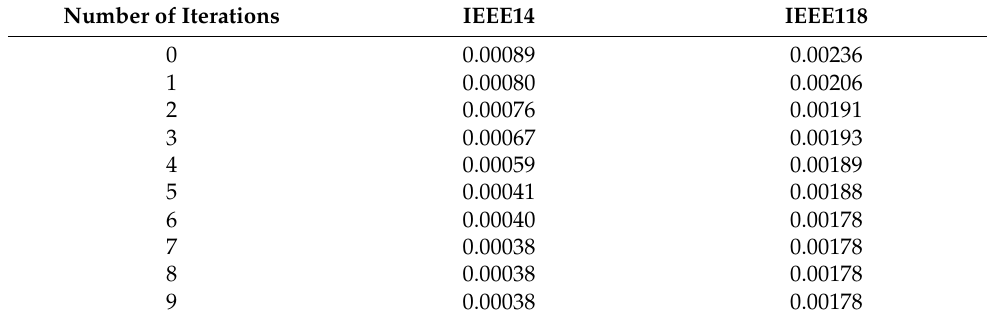
Table 3. Iterative adaptation values for the IEEE14-bus and IEEE118-bus test systems.